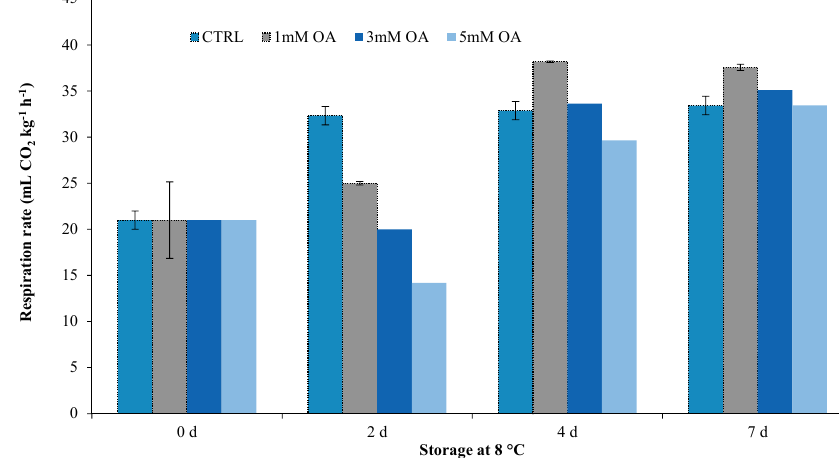
Figure 1. Respiration rate measured during the storage at 8 °C in fresh-cut iceberg lettuce dipped with different oxalic acid (OA) concentrations respect to control samples (CTRL).